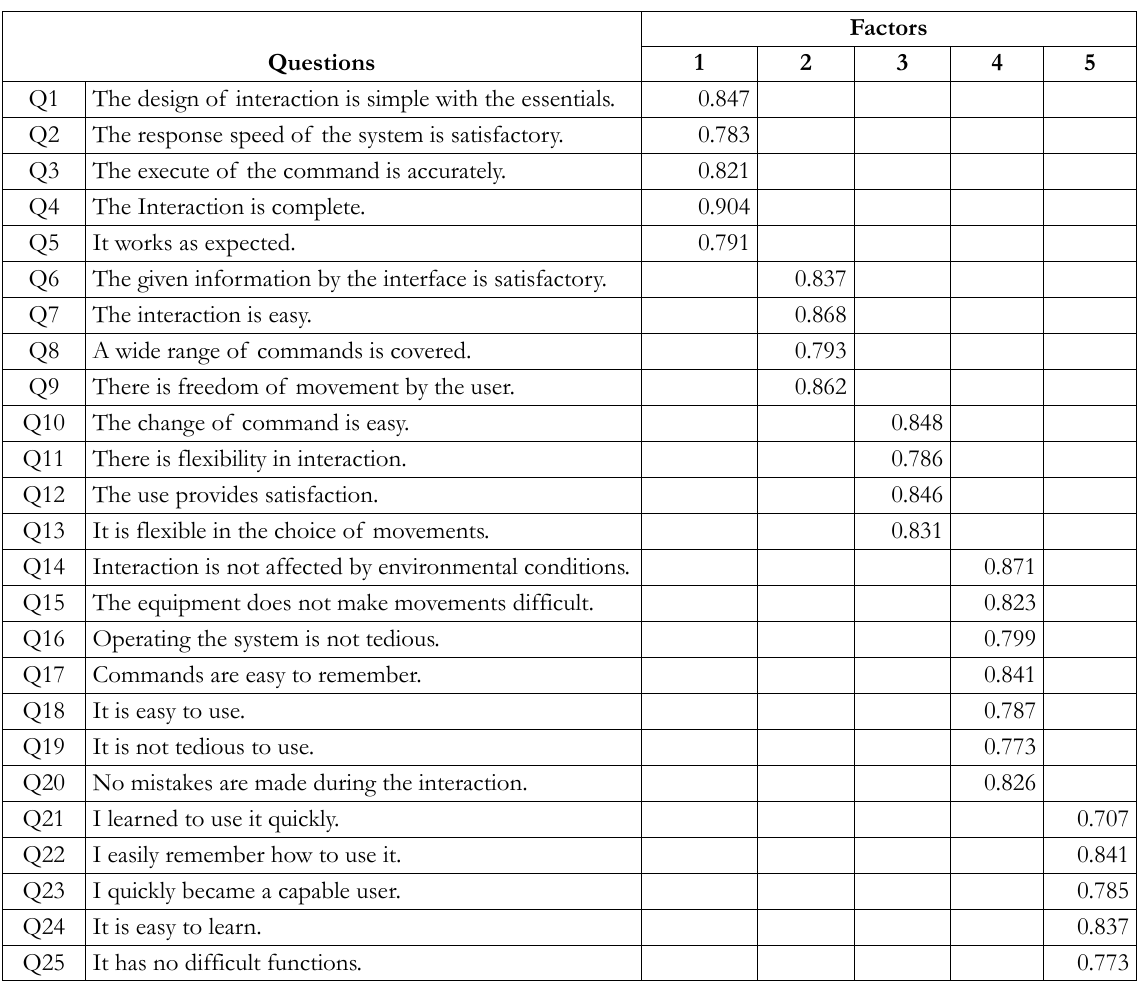
Table 1. Principal Component Analysis